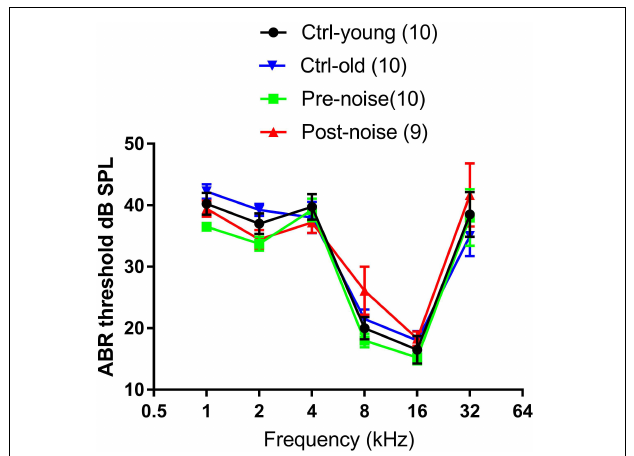
FIGURE 1 | The effect of age and noise on ABR thresholds. Ctrl-young and Pre-noise were the baseline thresholds taken at 1.5–2 months of age from both the control and noise groups before the noise exposure. Ctrl-old was measured at 4–5 months of age (from the control group), which matched the age of the noise group for the ABR tested one month after the noise